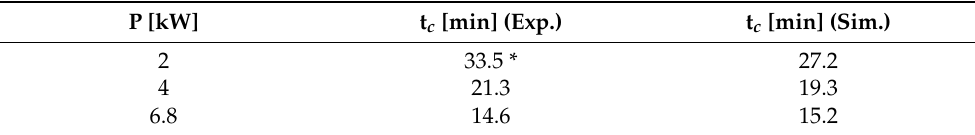
Table 4. Central variation parameters: average inventory temperature ( T(cid:3365) (cid:3010) ) at the end of charging period, total mass flow rate ( m(cid:4662) ), constant mixing temperature ( T (cid:3042)(cid:3048)(cid:3047) ). 𝐓(cid:3365) 𝑰 [°C]